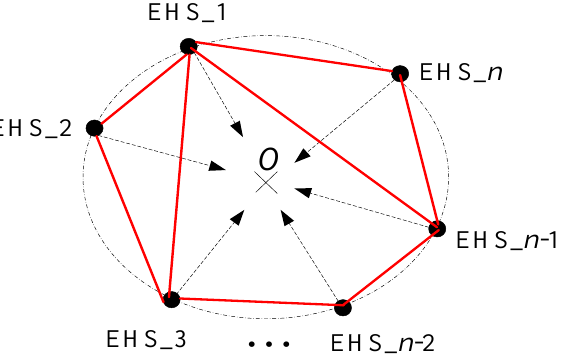
Figure 1. The synchronous control scheme for MEHAs’ average consensus in a network topology based on undirected graph